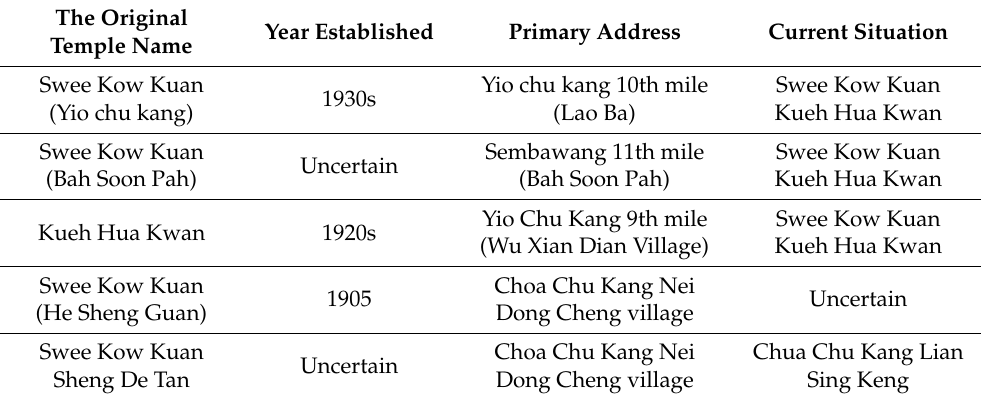
Table 1. The Hong Clan Ancestral temple at Weng Shan,